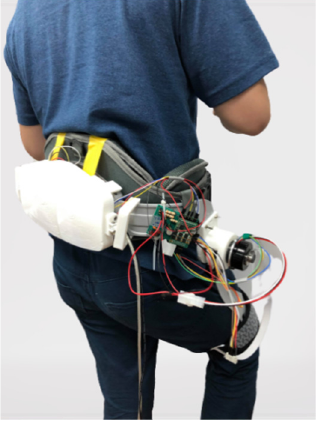
Figure 7. A subject wearing the robotic hip exoskeleton.